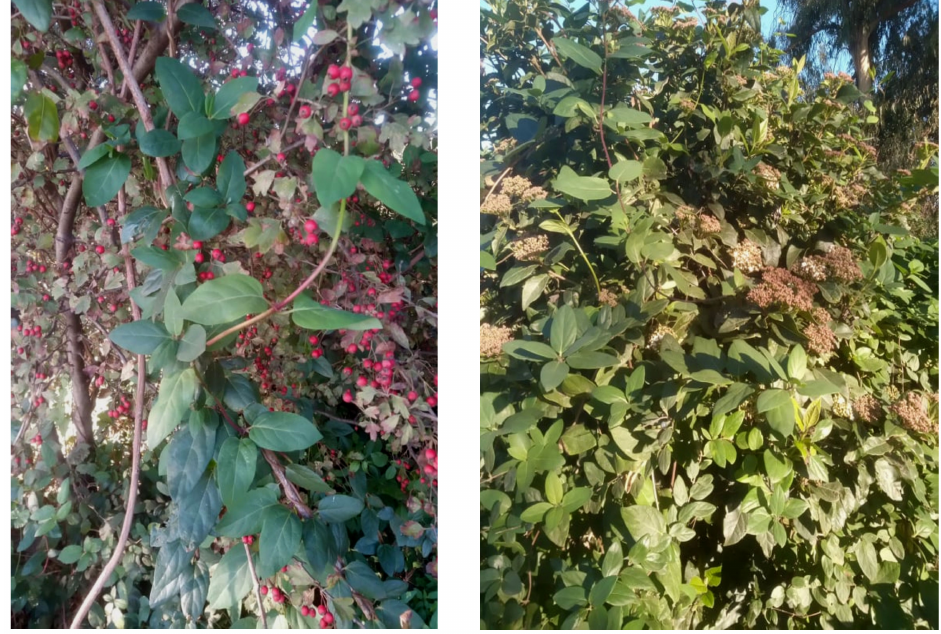
Figure 86. Lonicera japonica on Crataegus monogyna ( left photo) and Viburnum tinus ( right photo) (Acquedotti